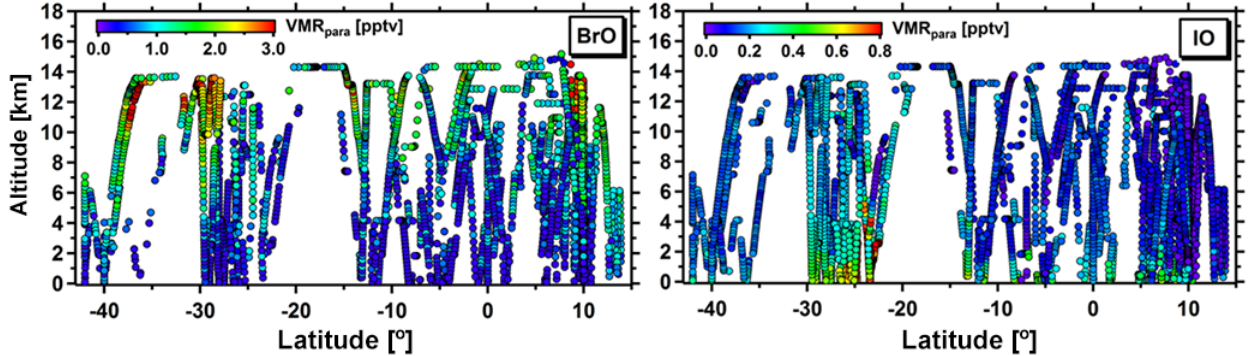
Figure 9. TORERO AMAX-DOAS BrO (left) and IO (right) VMR para data for the complete campaign. Plotted are aircraft altitudes over latitude, color coded by VMR para . Longitudes covered are 70 to 105 ◦